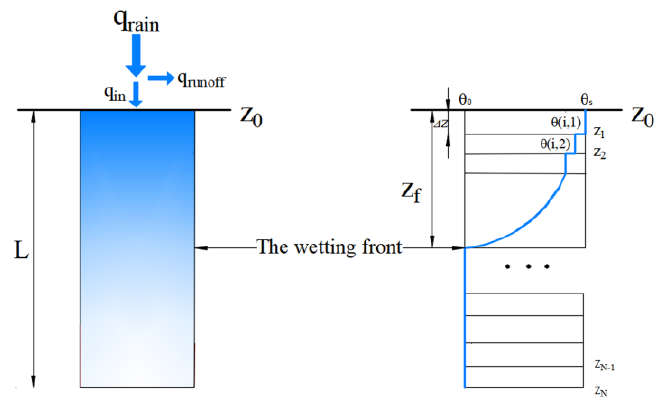
Figure 1. Spatial discretization of homogeneous soil column.